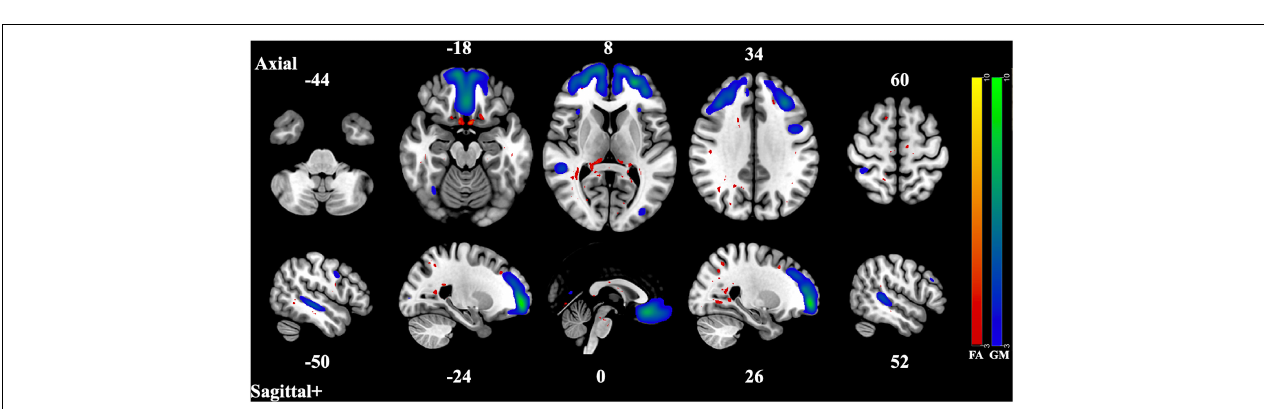
FIGURE 3 | Component Pair 3, Intermodal spatial map highlighting the correlated FA and GM changes that differ significantly (Bonferroni-corrected for multiple comparisons), HC > SZ, z > |3|. pICA correlation between structural networks, r = 0.46 ( t = 6.45, p = 1.36 × 10 – 9 ). FA cases vs. controls differences, t = 3.5, p = 0.00053, GM cases vs. controls, t = 2.92, p = 0.0041. Red-yellow represents the FA group differences, blue-green represents the GM group differences. See Supplementary Figures 5–6 for full axial and sagittal